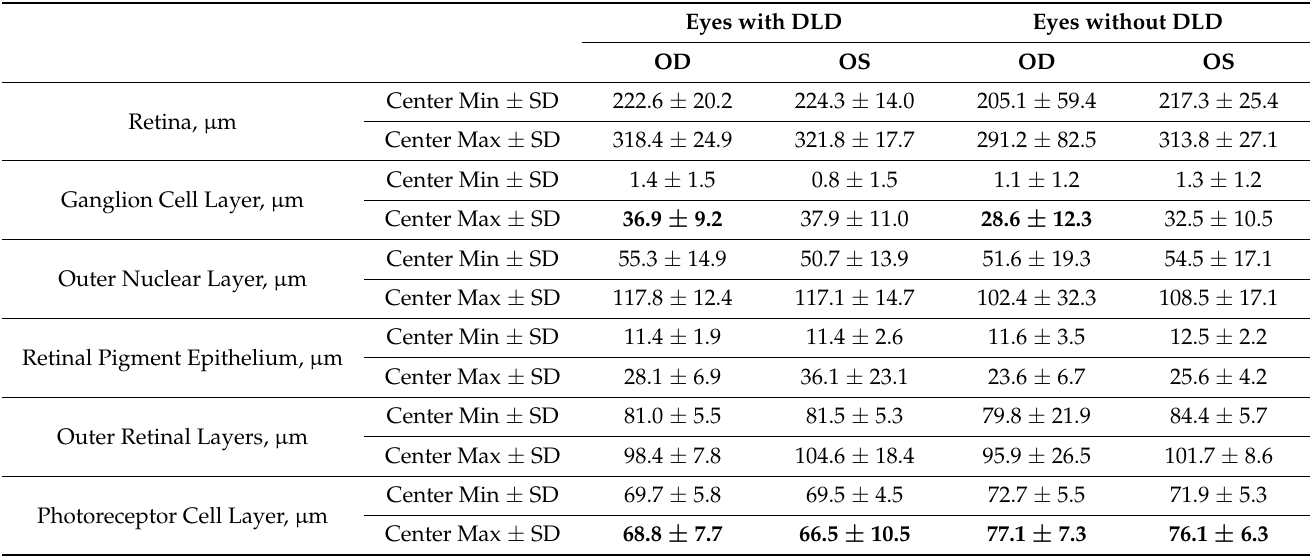
Table 4. Retinal layer analysis. Significant differences shown in bold type. SD, standard